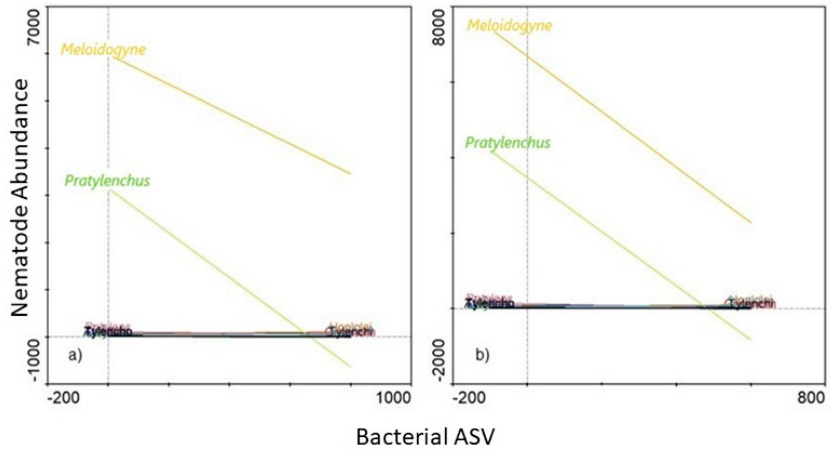
Figure 10. A functional response graph showing the correlation between the abundance (Bacterial ASV) of the genera Ambiguous_taxa10 ( a ), Roseiflexus 2 ( b ) nematode abundance of the abundance of Meloidogyne (orange line) and Pratylenchus (green line) that were extracted from soybean roots sampled from the Highveld production area in the Mpumalanga province, South Africa.